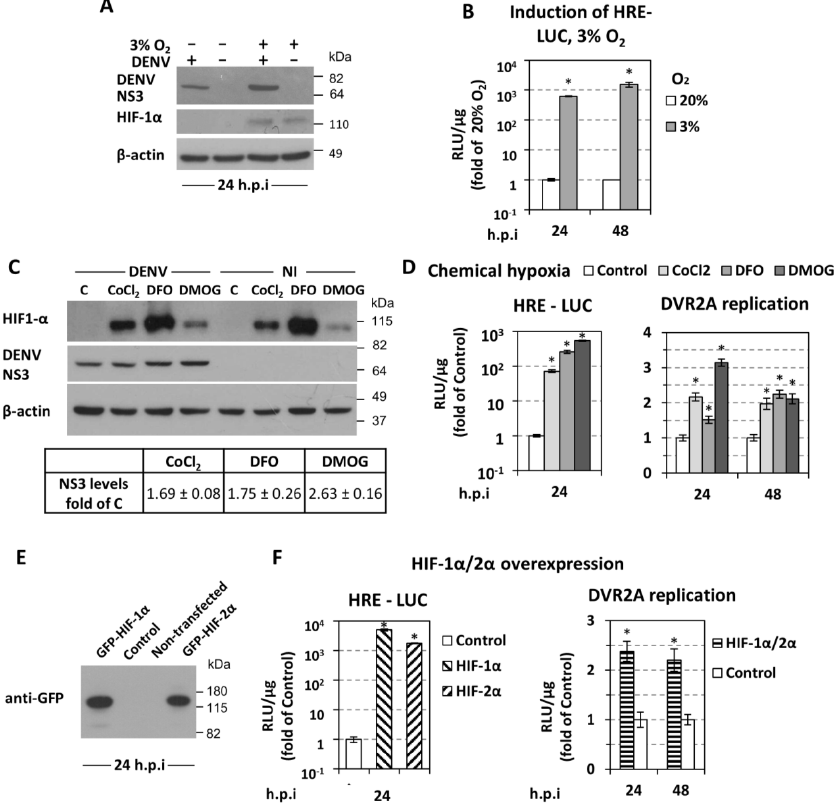
Figure 5. HIF upregulation enhances DENV replication. ( A ) Western blot analysis of DENV NS3 (top), HIF-1 α (middle), and β -actin (bottom) of DENV-infected (MOI 0.5) or non-infected cells, incubated as specified on top of each lane and lysed at 24 h p.i. β -actin served as a loading control. A representative experiment of 3 independent repetitions is shown. ( B ) Activation of HRE (hypoxia response element) by low oxygen. Huh7 cells were transfected with the 9 × HRE-Luc construct (0.4 µ g/4 × 10 4 cells), 4 h post-transfection inoculated with DENV (MOI 0.5) for 4 h and further incubated at 20% or transferred to 3% O 2 for 24 or 48 h p.i. HRE-dependent F-Luc activity was measured and expressed as RLU/ µ g of total protein amount. Values obtained from cells incubated at 20% O 2 were set to one each time. * p < 0.001 vs. 20% O 2 cells (Student’s t -test). ( C,D ) Chemically-induced hypoxia stabilizes HIF-1 α and enhances DENV replication. ( C ) (Top) Western blot analysis of HIF-1 α (top) DENV NS3 (middle) and β -actin (bottom) of Huh7 cells inoculated with DENV (MOI 0.5) for 4 h, and subsequently treated, for 24 h, with CoCl 2 (75 µ M), DFO (37.5 µ M), or DMOG (62.5 µ M), as specified on top of each lane. β -actin served as loading control. A representative experiment is shown. C: control non-treated cells. (Bottom) Quantification of NS3 signals from 3 independent experiments, normalized to the β -actin loading control was performed and mean values are expressed relative to that obtained from control cells. ( D ) Luciferase activity obtained with Huh7 cells transfected with the 9 × HRE-Luc construct (left) or infected with DVR2A (MOI = 0.01, right) were treated with CoCl 2 (75 µ M), DFO (37.5 µ M), or DMOG (62.5 µ M) at 6 h post-transfection or 4 h post virus inoculation, respectively. Cells were lysed at the indicated time-points. Mean values are expressed relative to the reporter activity derived from control-non treated cells. ( E , F ) Overexpression of HIF-1 α and HIF-2 α enhances DENV replication. Huh7 cells were either co-transfected with the 9 × HRE-Luc construct and a plasmid that expresses GFP-HIF-1 α , GFP-HIF-2 α , or empty vector (control), or first transfected with both HIF-expressing plasmids and 18 h later infected with DVR2A (MOI 0.1). ( E ) Western blot analysis of GFP-HIF-1 α and GFP-HIF-2 α using an anti-GFP antibody. ( F ) HRE-dependent F-Luc (left) and DVR2A-derived R-Luc (right) were measured and expressed as RLU/ µ g of total protein amount. Values of control cells were set to one for each time point. In all panels, bars represent mean values from at least three independent experiments in triplicate. Error bars indicate standard deviations. * p < 0.001 vs. control